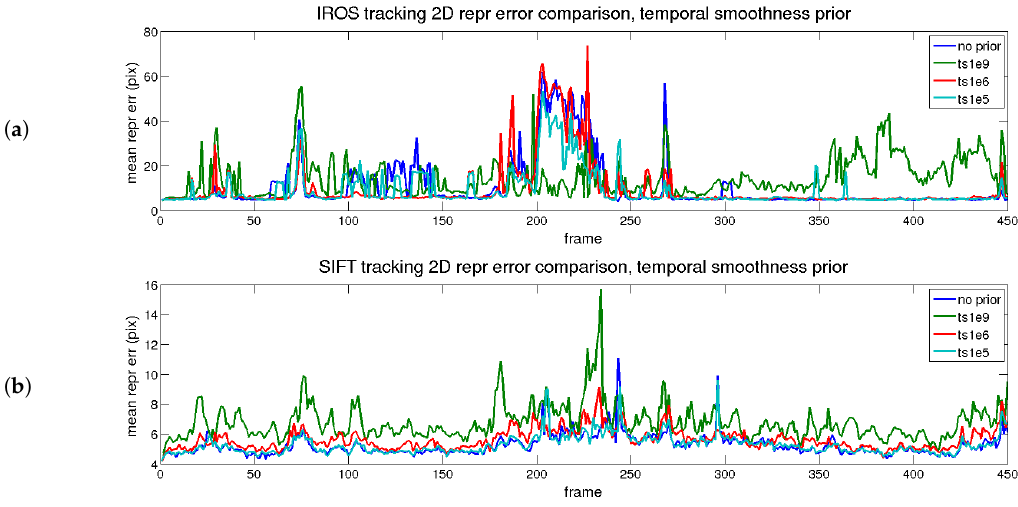
Figure 8. Rendered flag sequence: reprojection error results over time when the time smoothness prior is applied for both descriptor types. ( a ) IROS; ( b )